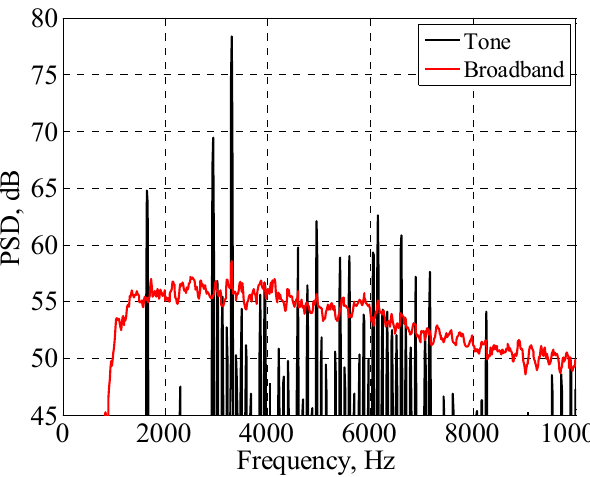
Figure 3. Tone and broadband noise spectra from a single-shaft fan calculated using phase-averaging.